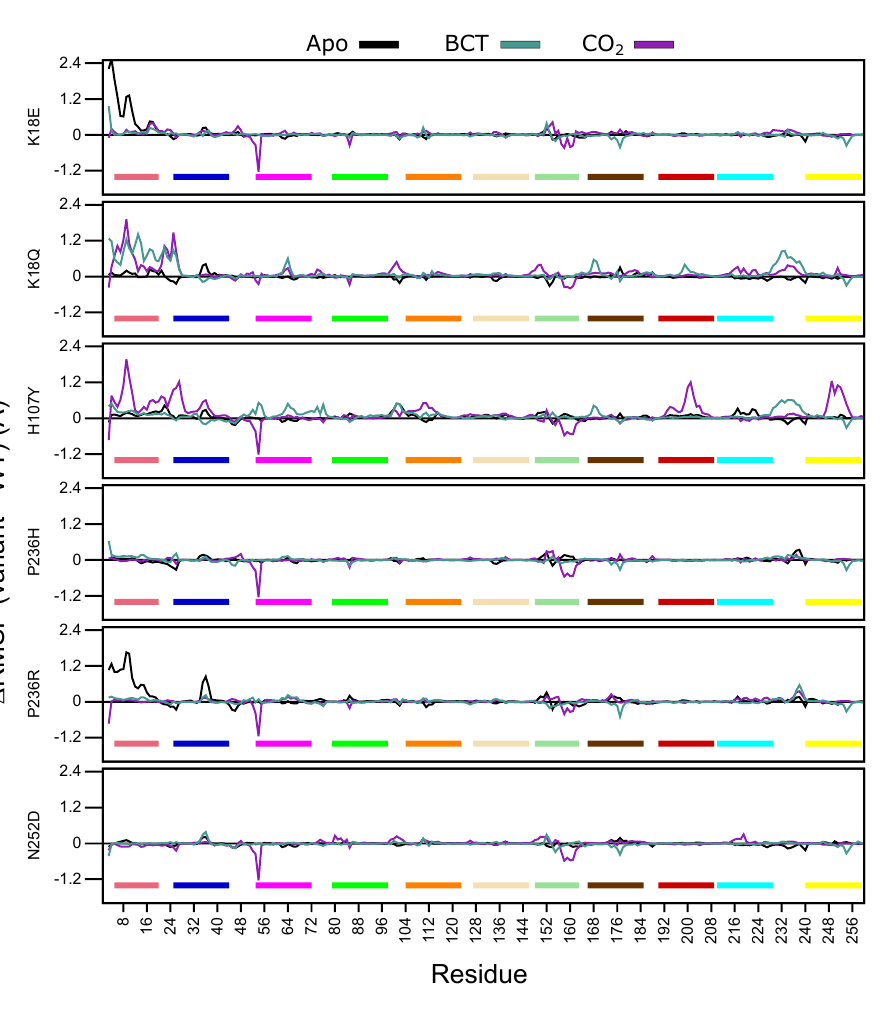
Figure 5. ∆ α -carbon RMSF comparison of the WT and variant proteins (variant minus WT). Respective motifs are indicated as bars at the bottom of each plot. Motif colors correspond to those in Figure